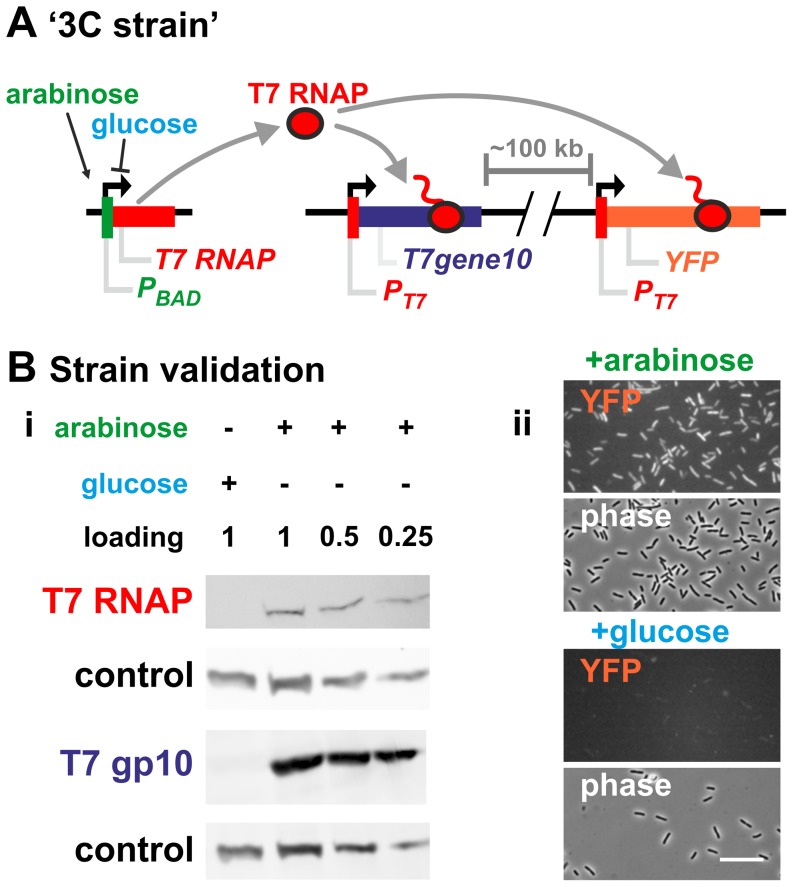
Validating the ‘3C strain’.
A. Diagram of the ‘3C strain’ genome. The strain expresses T7 RNAP (under control of a PBAD promoter) in the presence of arabinose, but not in the presence of glucose. T7 RNAP then transcribes two transgenes driven by T7 promoters – T7gene10 and YFP – integrated 100 kb apart in the bacterial chromosome. If active T7 RNAP clusters, these transgenes should interact in the presence of arabinose (i.e., when transcribed) but not glucose (i.e., when inactive). B. Validating ‘3C strain’. (i) Cells were grown to OD600 = 0.4 in media containing arabinose or glucose, and their protein content analyzed using SDS-PAGE and western blotting. Probing for T7 RNAP shows it is expressed in the presence of arabinose (induction) but not glucose (repression). Probing for T7gp10 shows the same pattern, confirming that the corresponding gene is transcribed by T7 RNAP. In both blots, NusA is used as a loading control. (ii) Cells from the ‘3C strain’ imaged using fluorescence microscopy. YFP is detected when cells are grown in the presence of arabinose (+T7RNAP) but not glucose (−T7RNAP), confirming that its gene is transcribed by T7 RNAP. Both YFP images have the same intensity scale. Bar: 20 µm.